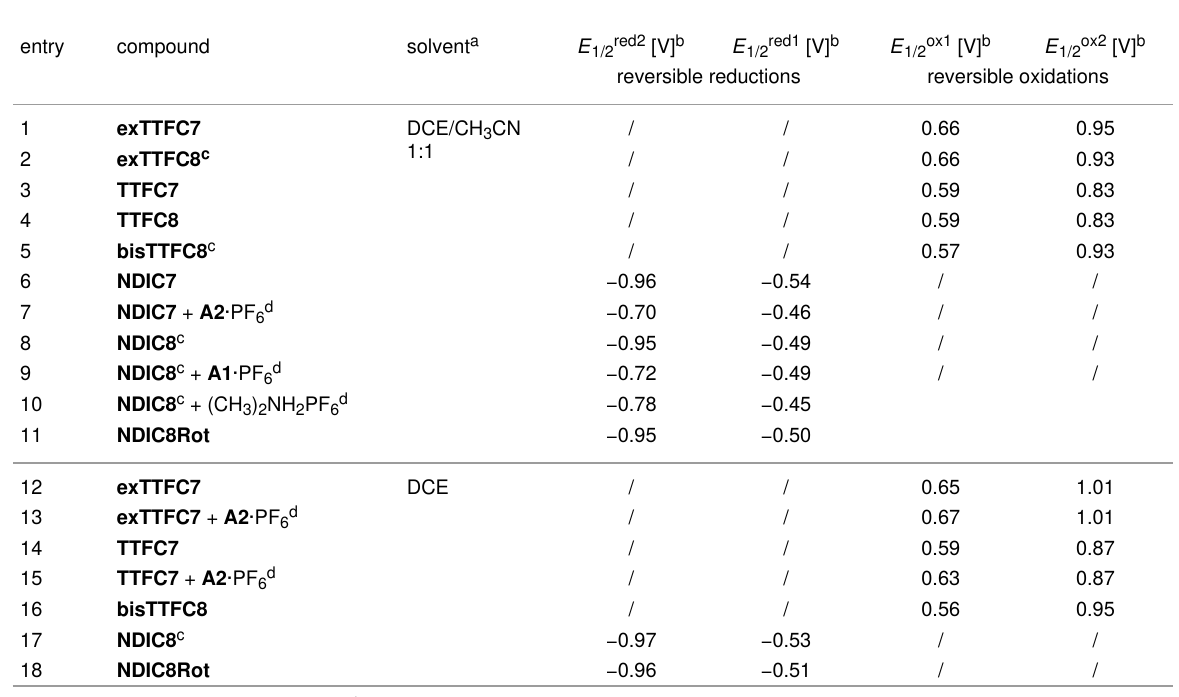
Table 2: Electrochemical data obtained by differential pulse voltammetry (for voltammograms and experimental details see Supporting Information File 1, section 4).